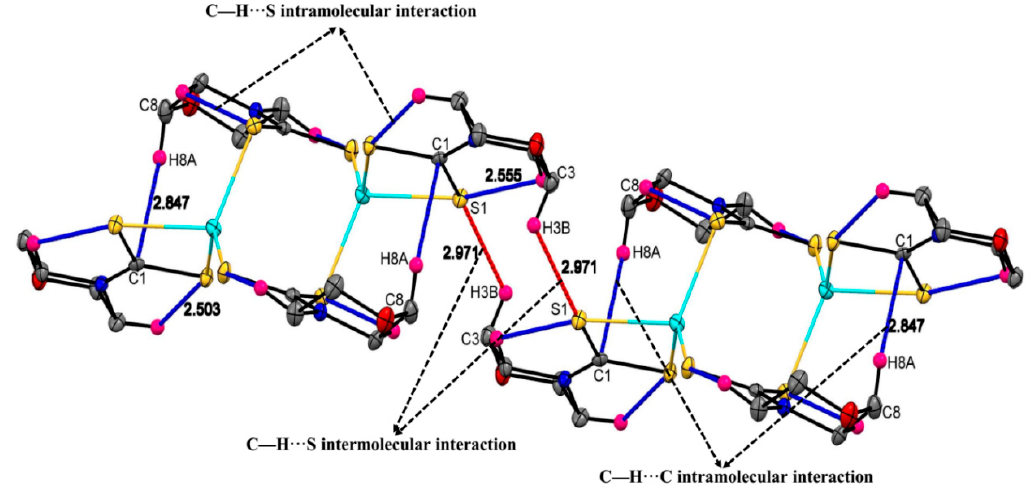
Figure 3. Molecular structure of [Zn( μ -MphDTC) 2 (MphDTC) 2 ] showing an atomic labeling displacement ellipsoid at a 50% probability.